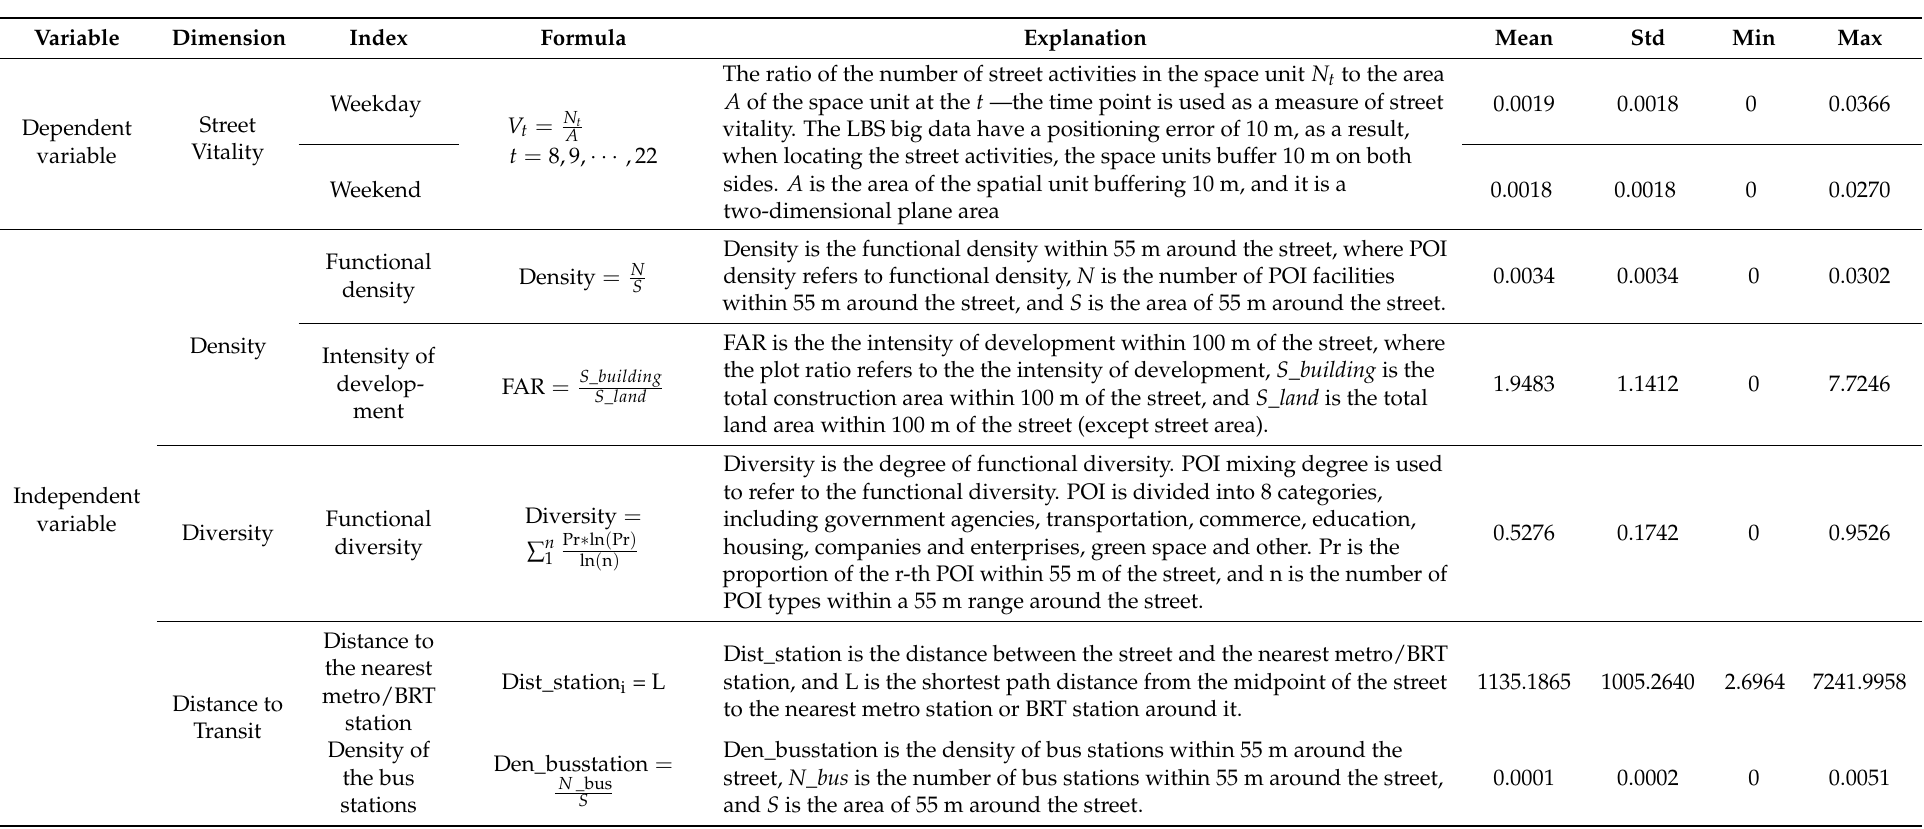
Table 1. Index system and statistical